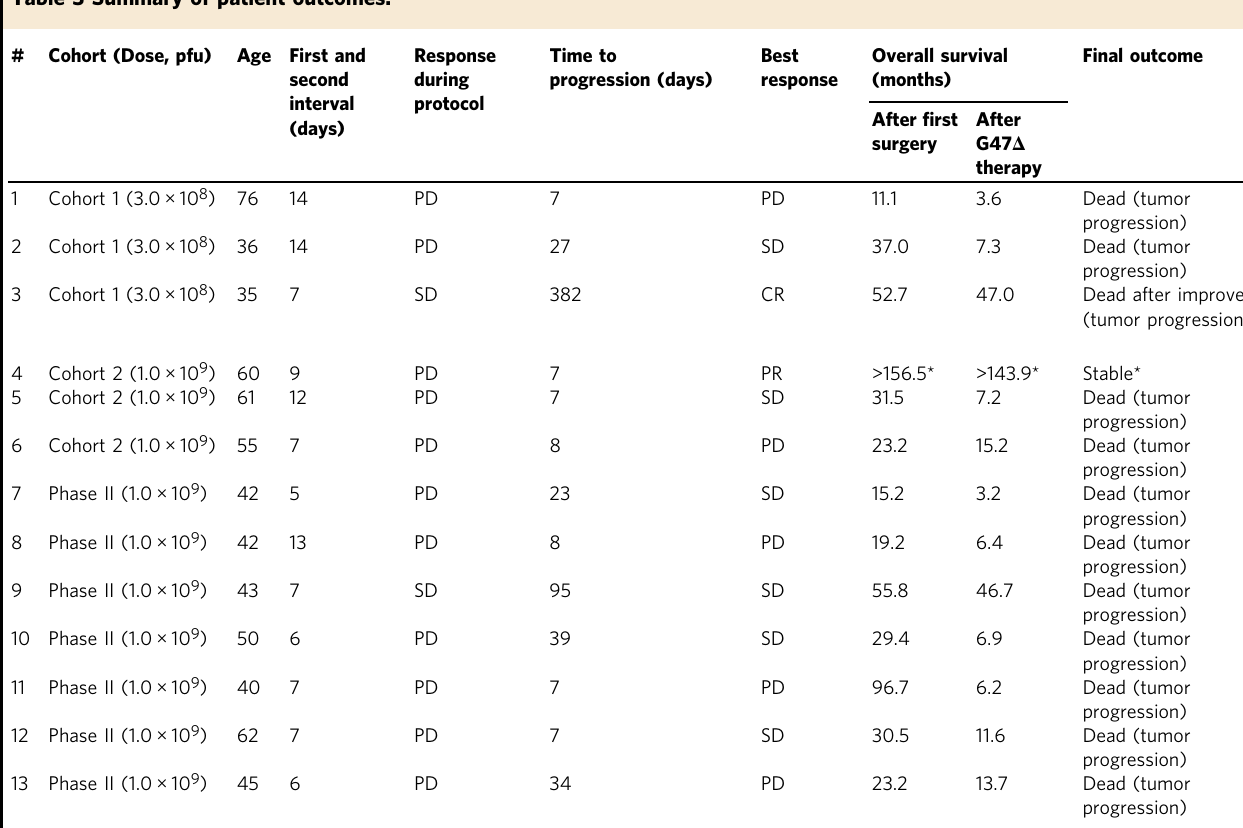
Table 3 Summary of patient